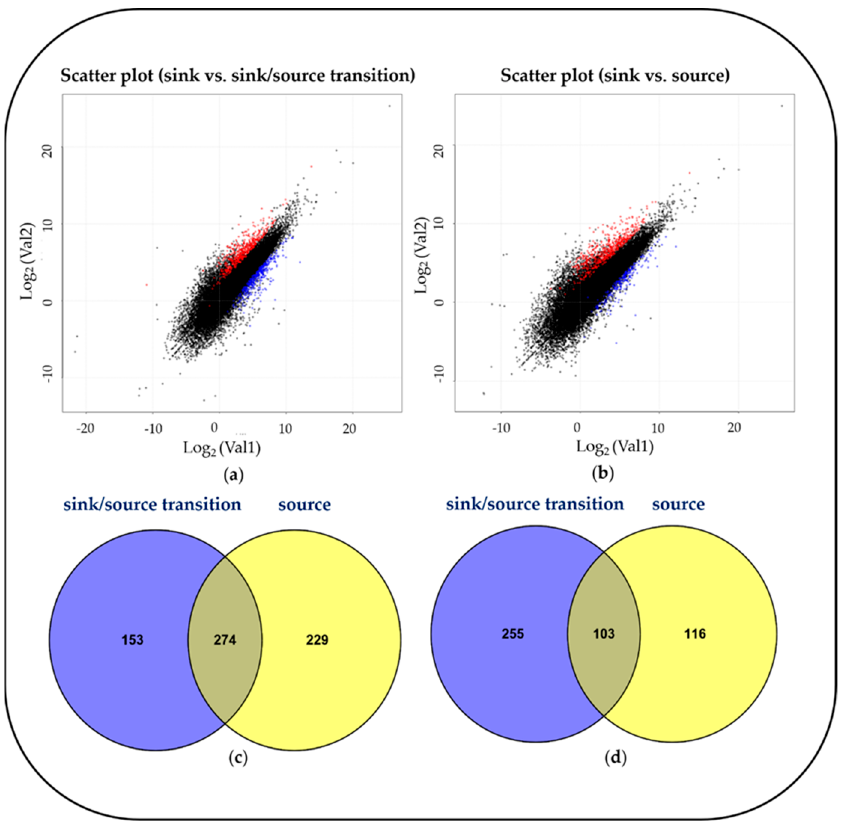
Figure 2 . Scatter plot showing correlation between expressed genes. ( a ) Sink vs. sink-to-source transition. ( b ) Sink vs. source. Red spots, log 2 fold change >1 and p -value < 0.05; blue spots log 2 fold change < -1 and p -value < 0.05. Venn diagram showing the overlapping ( c ) upregulated and ( d ) downregulated differentially expressed genes (DEGs) in sink-to-source transition or source compared to sink.